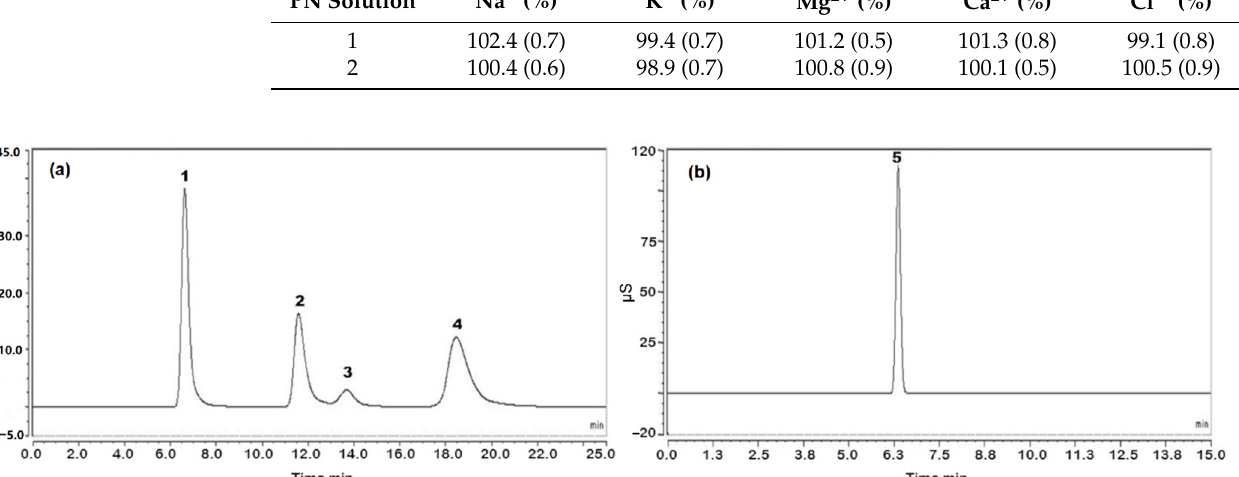
Table 8. Contents (RSD%, n = 6) of different ions following analysis of PN solutions.